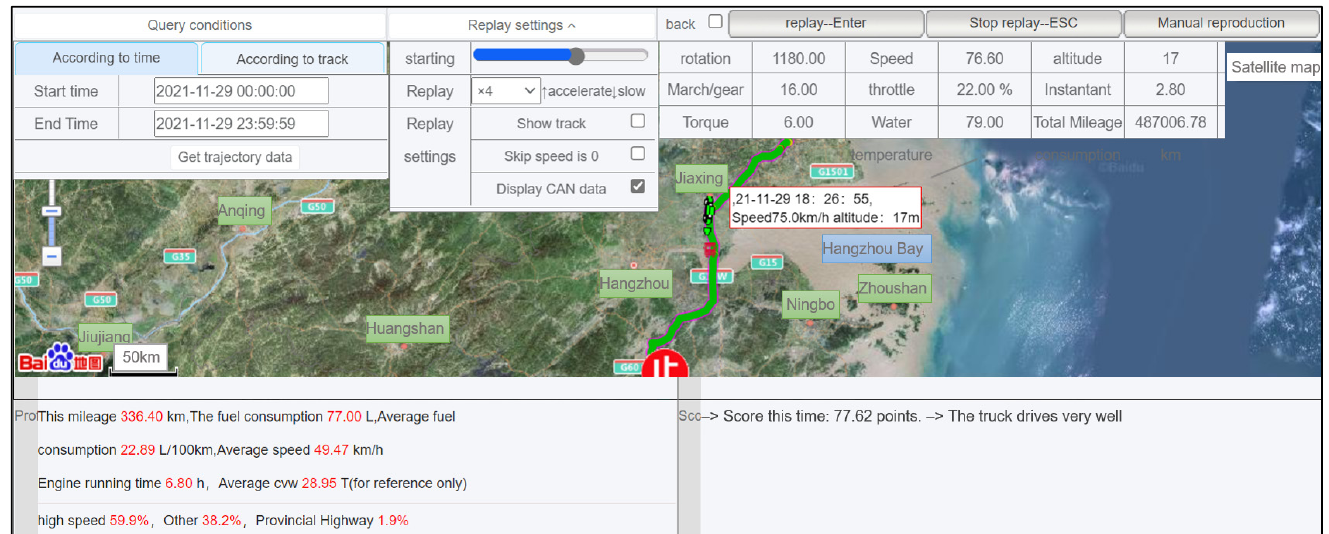
Figure 2. Operation page of SINOTRUK Intelligent Platform.